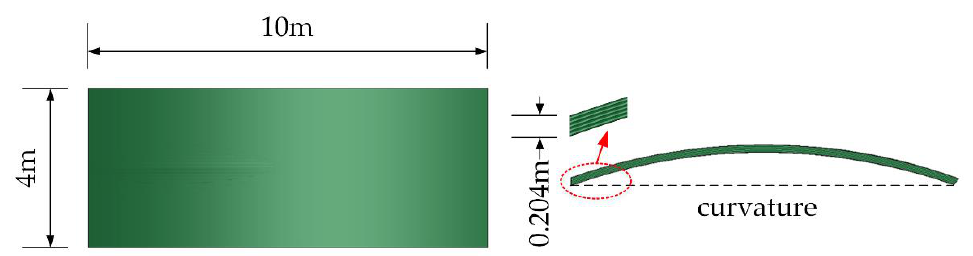
Figure 25. Dimensions of the blast wall.